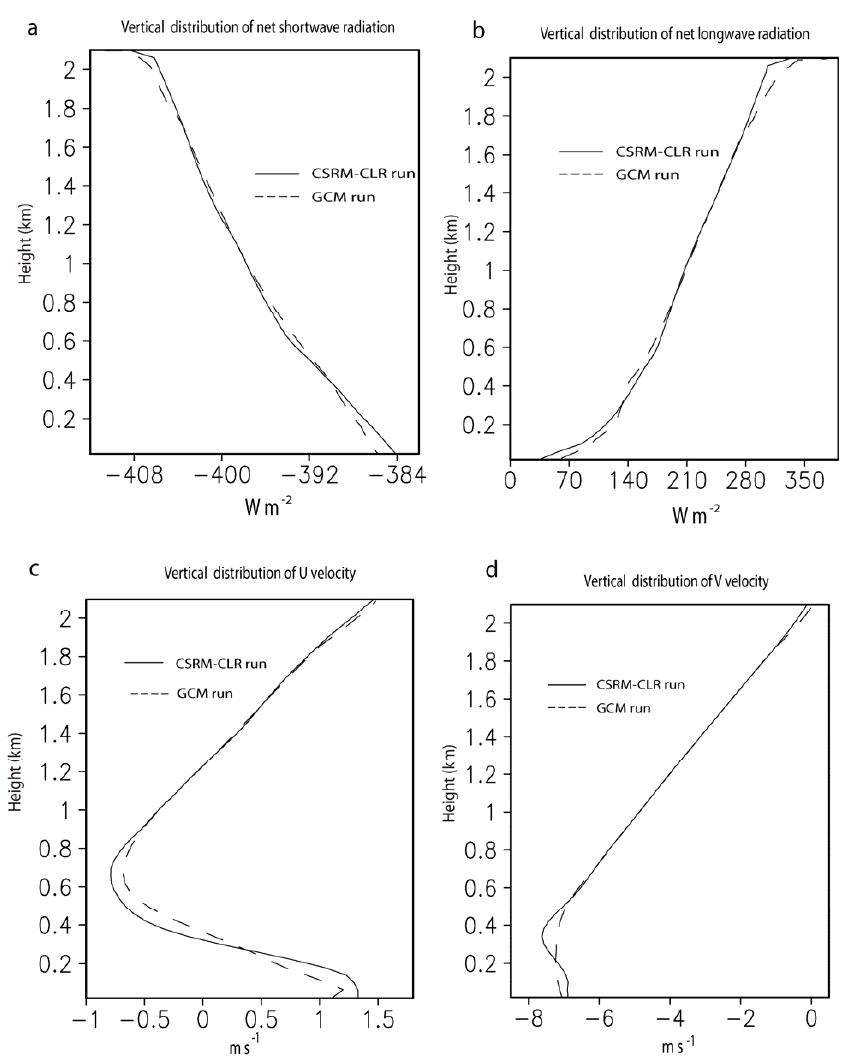
Figure 5 1391 Fig. 5. Vertical distribution of the time- and area-averaged (a) net shortwave fluxes, (b) net longwave fluxes, (c) u wind velocity, (d) v